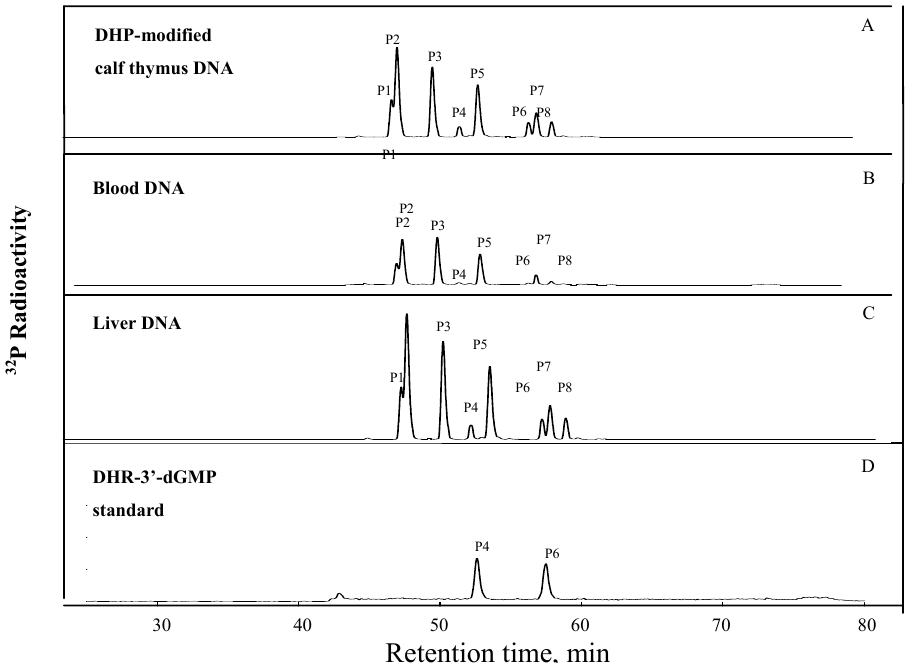
Figure 1. 32 P-Postlabeling/HPLC analysis of DHR-derived DNA adducts obtained from (A)reacting DHR with calf thymus DNA; (B) blood DNA from a female F344 rat treated by gavage with riddelliine; (C) liver DNA from a female F344 rat treated by gavage with riddelliine; and (D) synthetically-prepared DHR-3'-dGMP